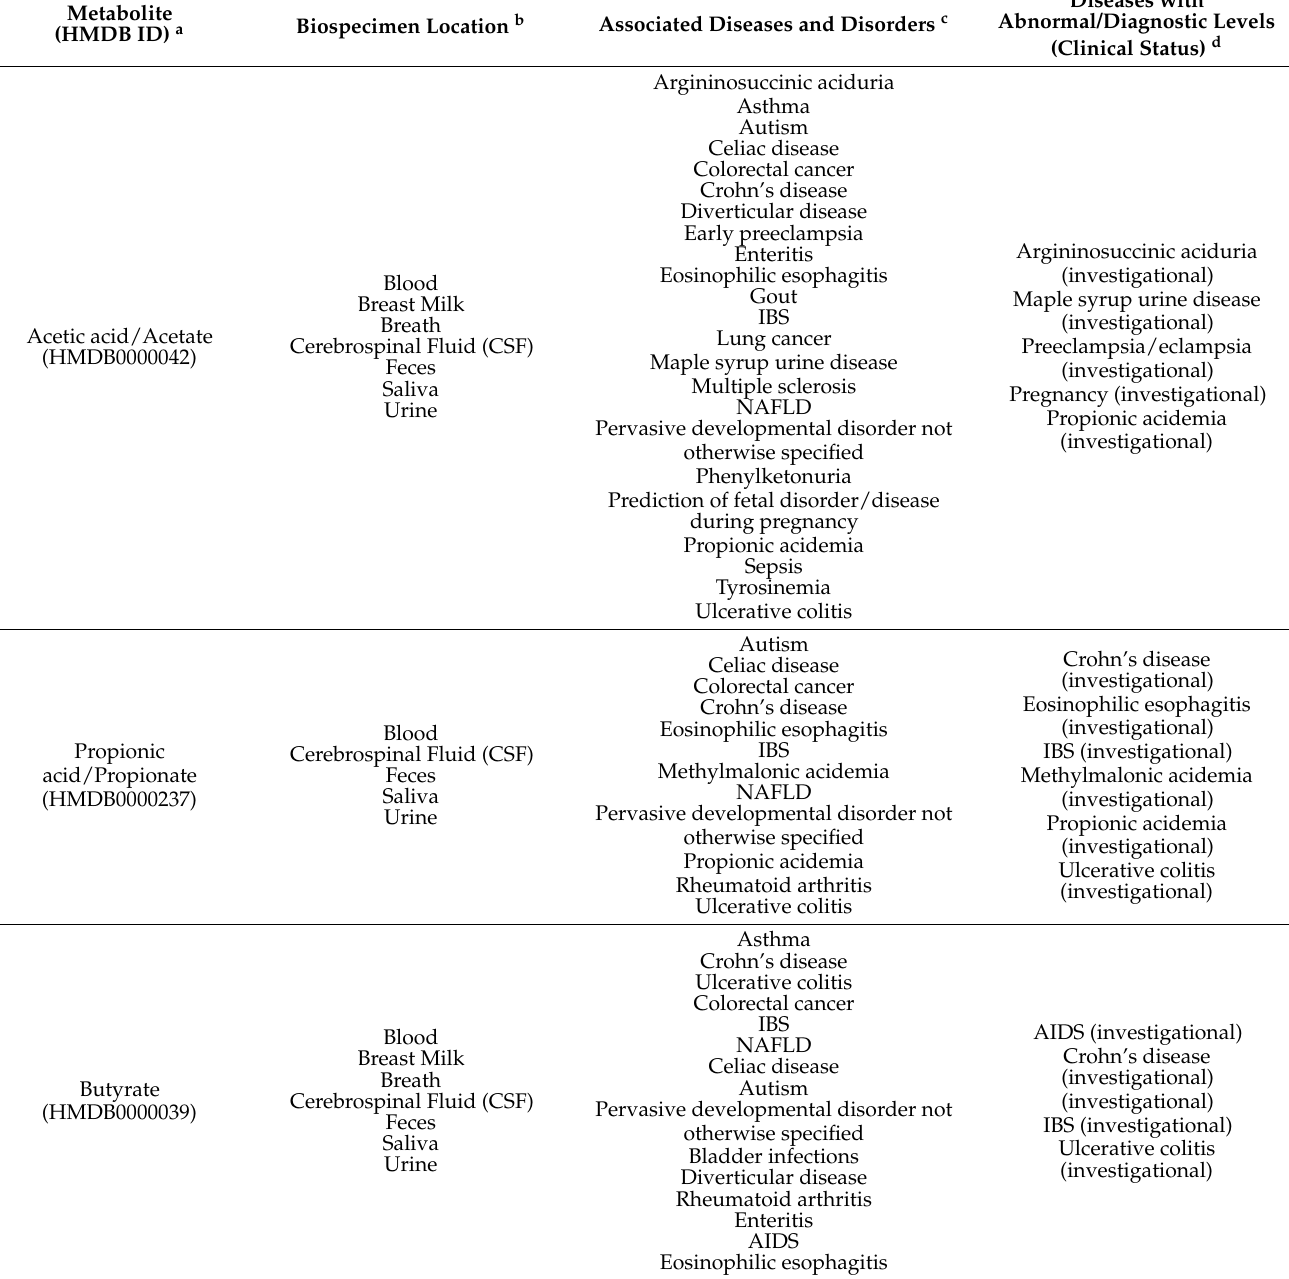
Table 1. Important microbiota metabolites that can be explored as diagnostic